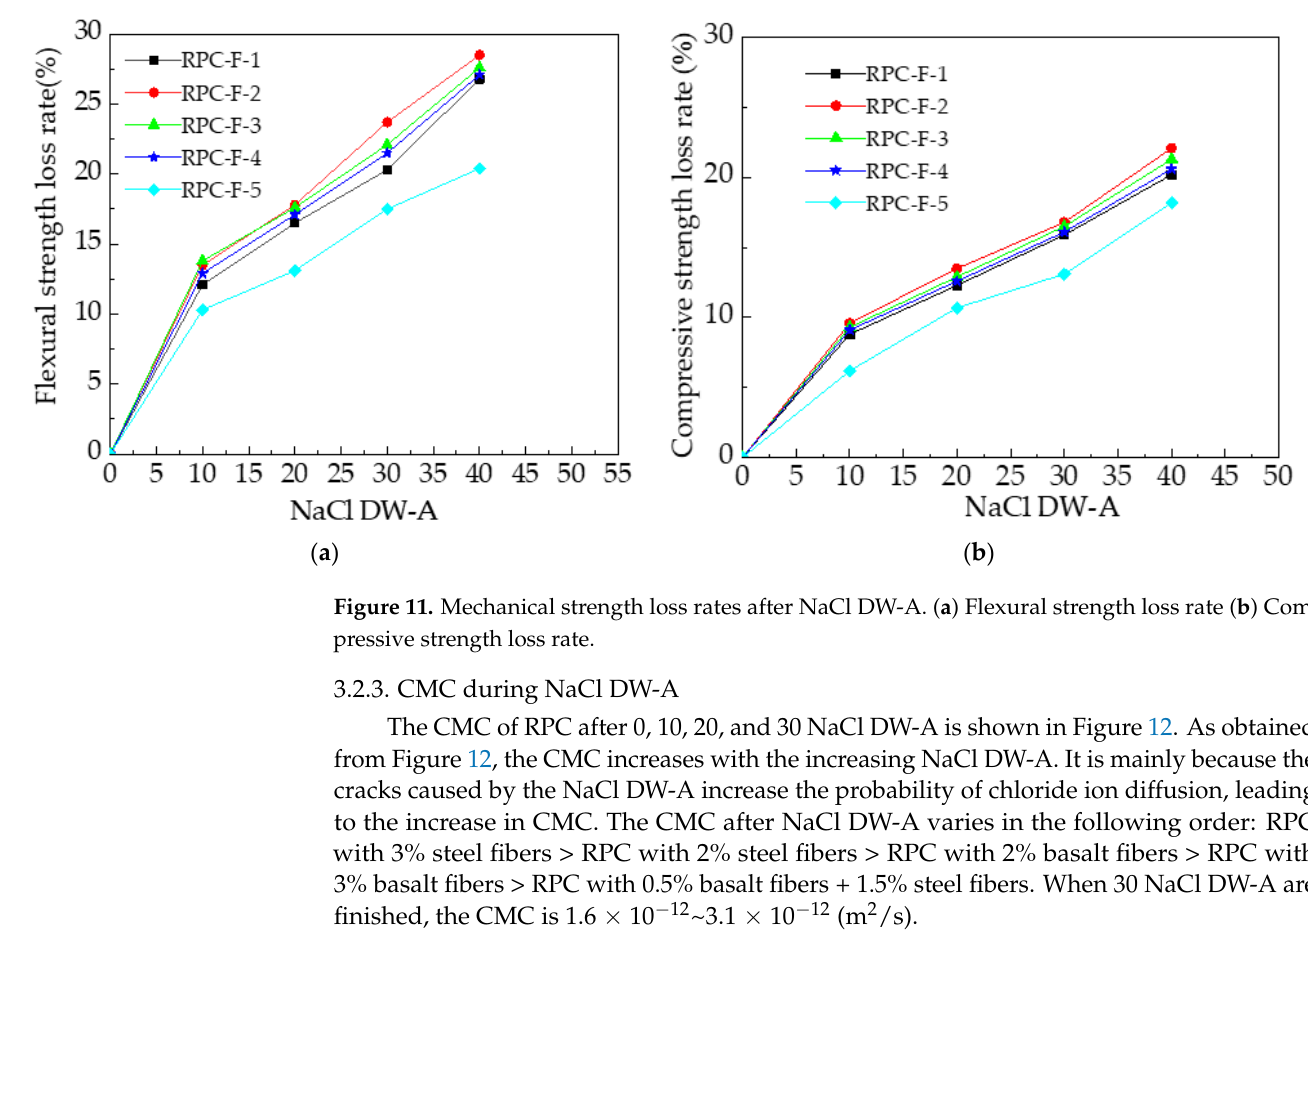
Figure 12. The CMC of RPC during NaCl DW-A. 3.2.4. Impact Toughness during NaCl DW-A The impact toughness of RPC after different NaCl DW-A is illustrated in Figure 13. As depicted in Figure 13, the impact toughness decreases obviously with the increasing NaCl DW-A. This is mainly because that the cyclic crystallization stress of RPC is gener- ated in the process of NaCl DW-A [35]. Hence, the cracks in RPC will expand, resulting in 0